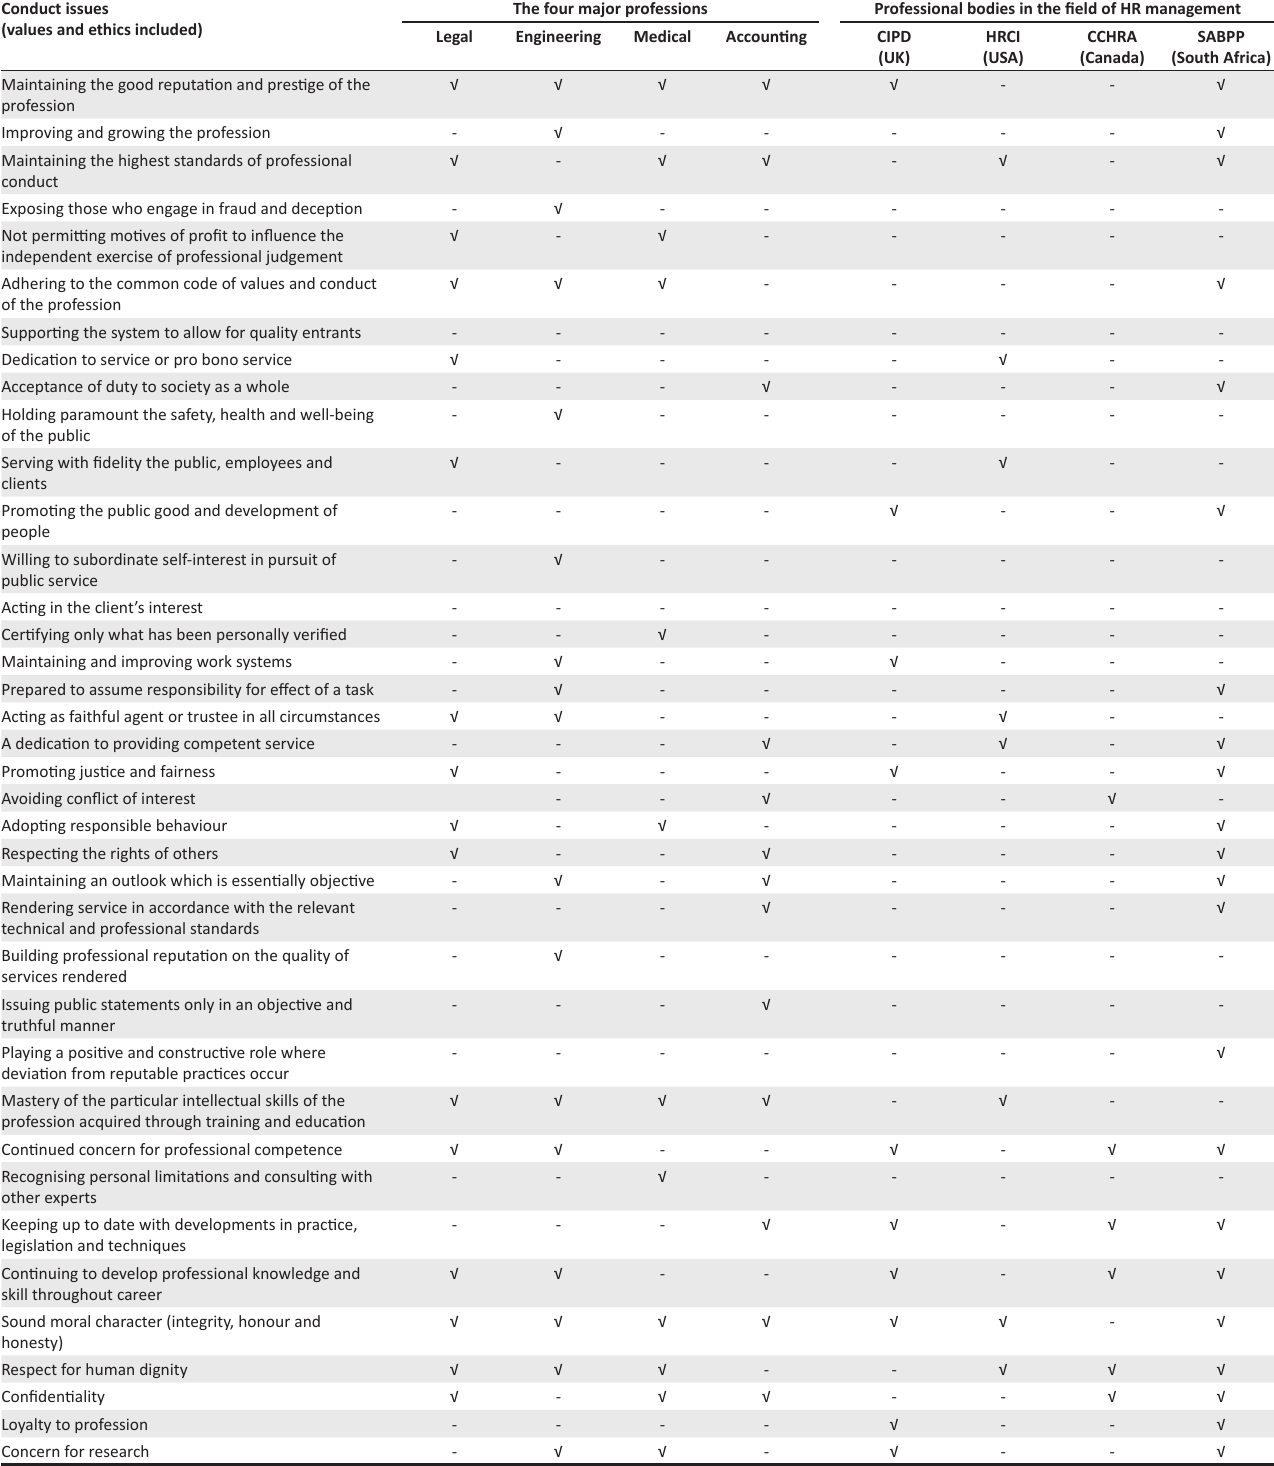
TABLE 2: Overarching comparative matrix of conduct